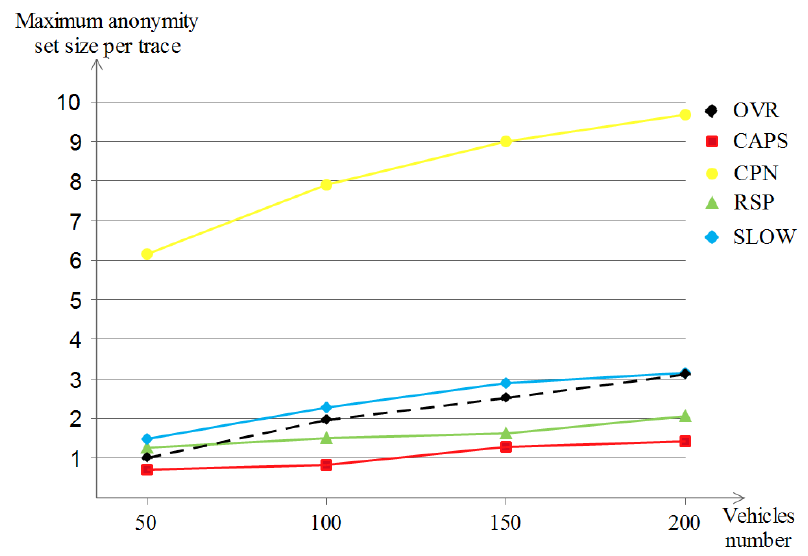
Figure 11. Maximum anonymity set size per trace of privacy schemes in the Manhattan